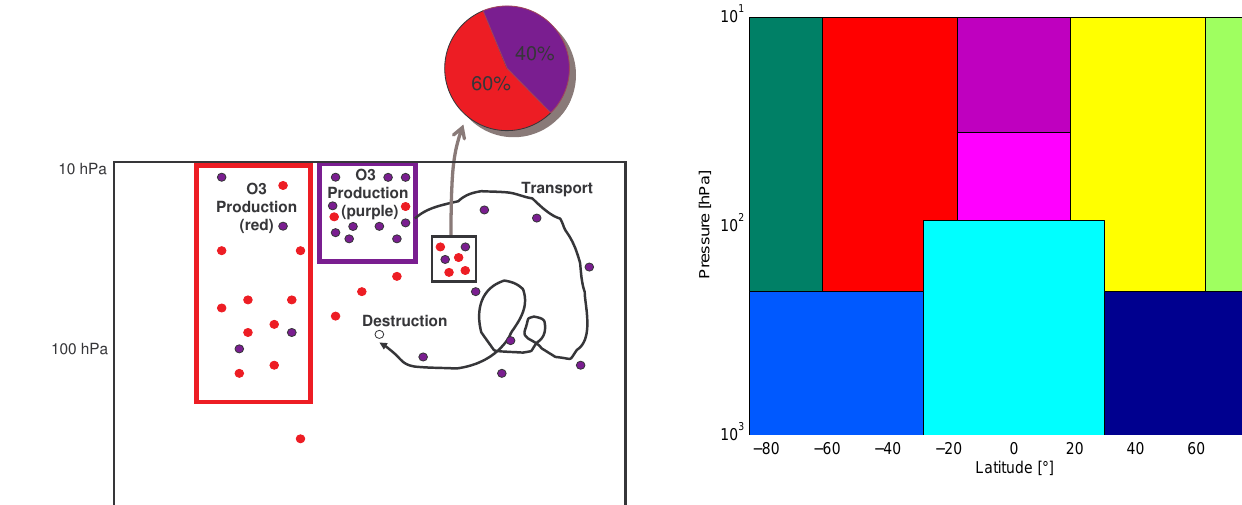
Fig. 2. Defined regions of the ozone origin diagnostic with each region being marked in one colour.